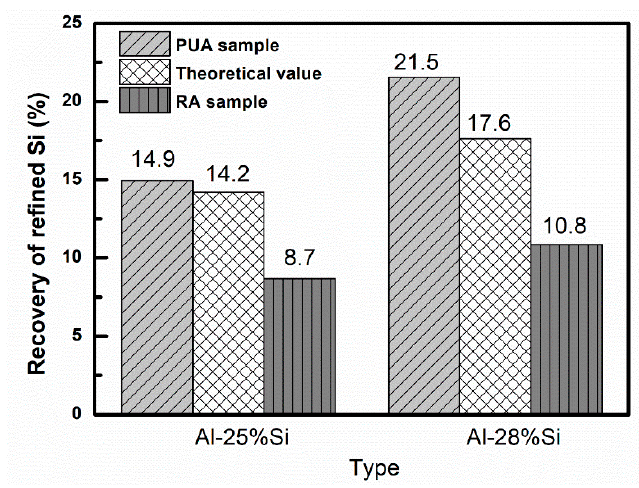
Figure 4. Recovery of refined Si with different Al–Si alloys.